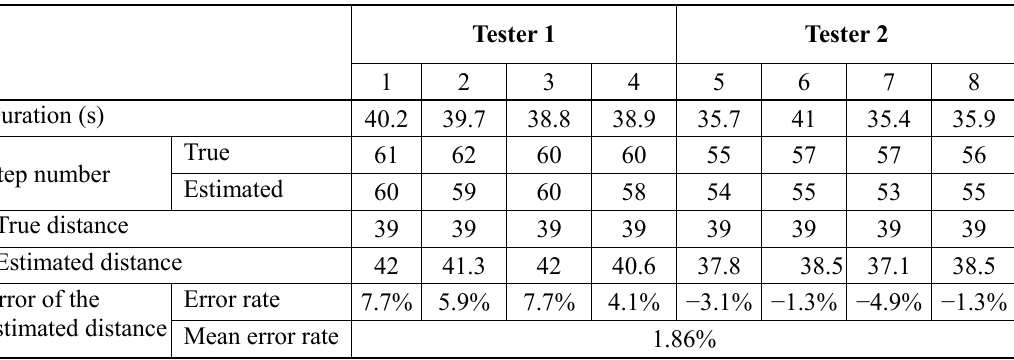
Table 3. The evaluation results for step detection and the distance moved estimation in the indoor office